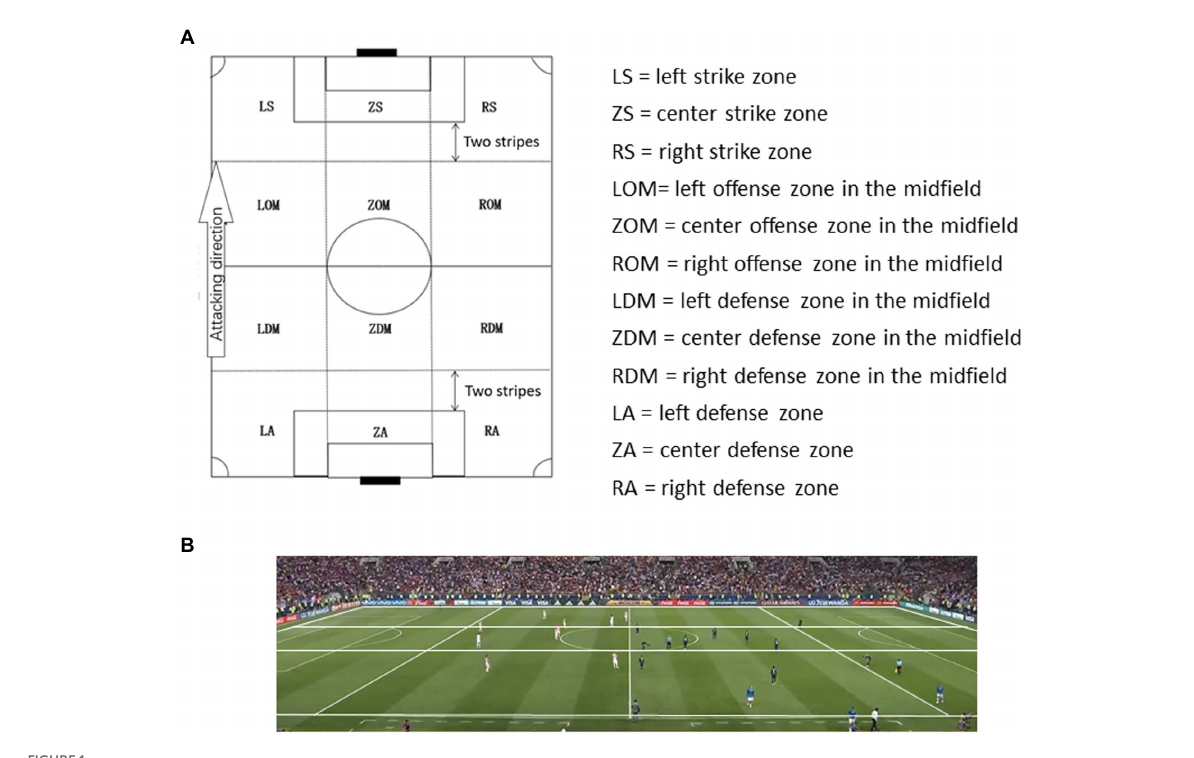
FIGURE 1 (A) Division of football ground. (B) Zone and turf band of football ground.